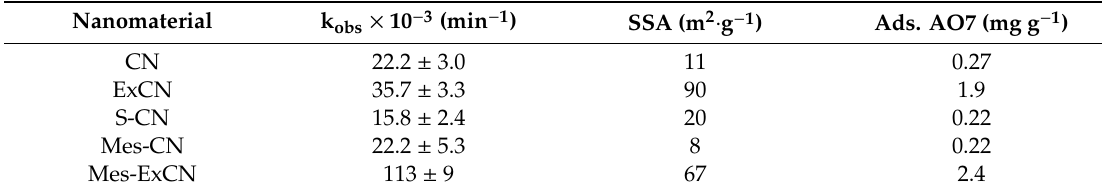
Table 3. Observed kinetic constants and specific surface area (SSA) of CN-based nanomaterials. AO7, Acid Orange 7.